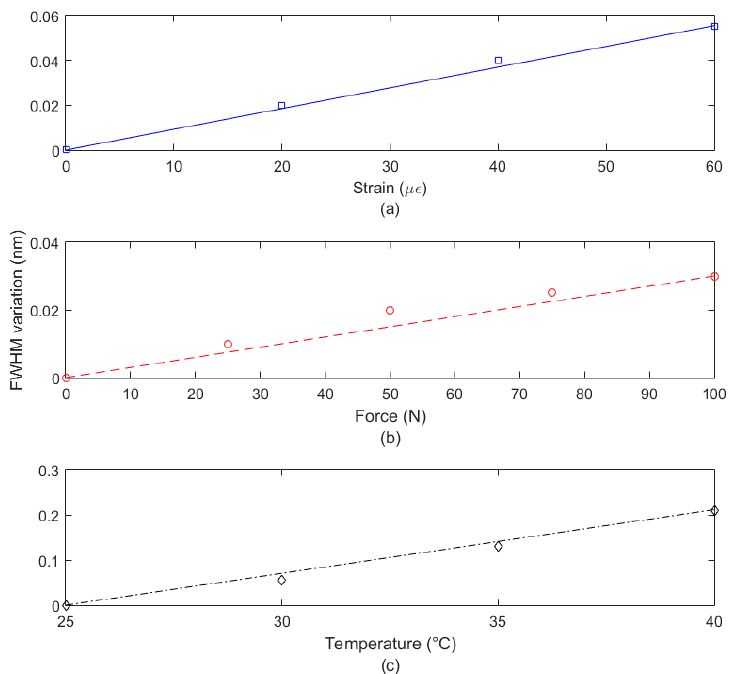
Figure 6. FWHM variation for the half-embedded TPU structure in the tests of ( a ) strain, ( b ) transverse force and ( c ) temperature.